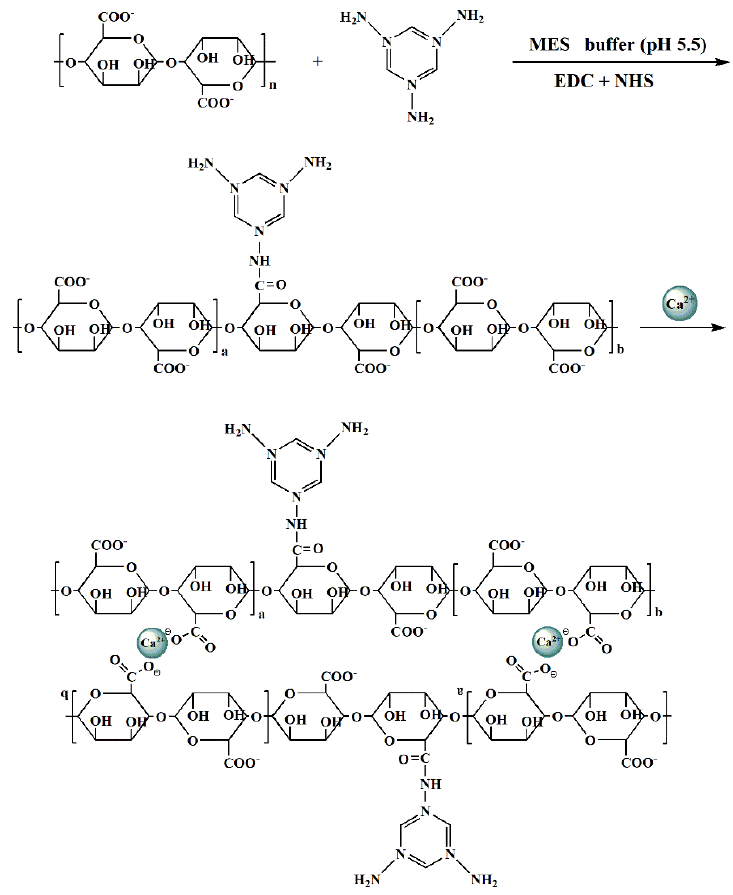
Figure 1. Preparation route of the Alg-Mel.